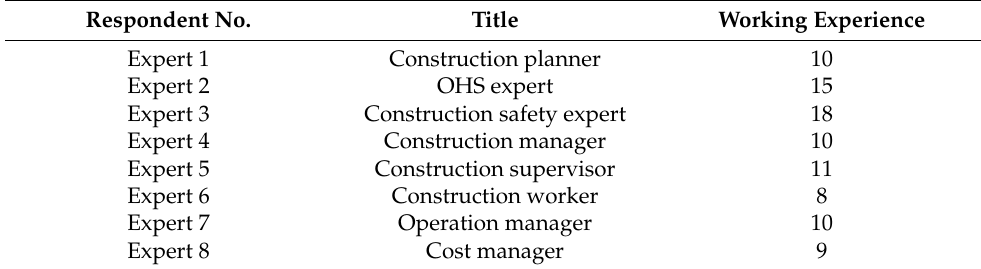
Table 5. Details about experts and working experience. Respondent